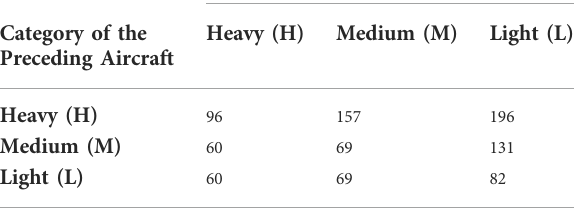
TABLE 2 Separation matrix indicating separation time in seconds between different aircraft categories. Category of the Following